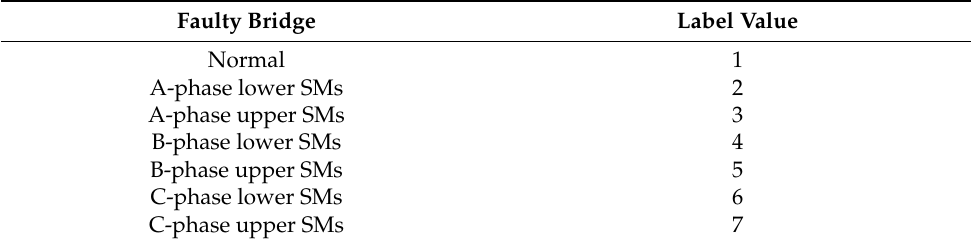
Table 3. MMC health conditions [6].